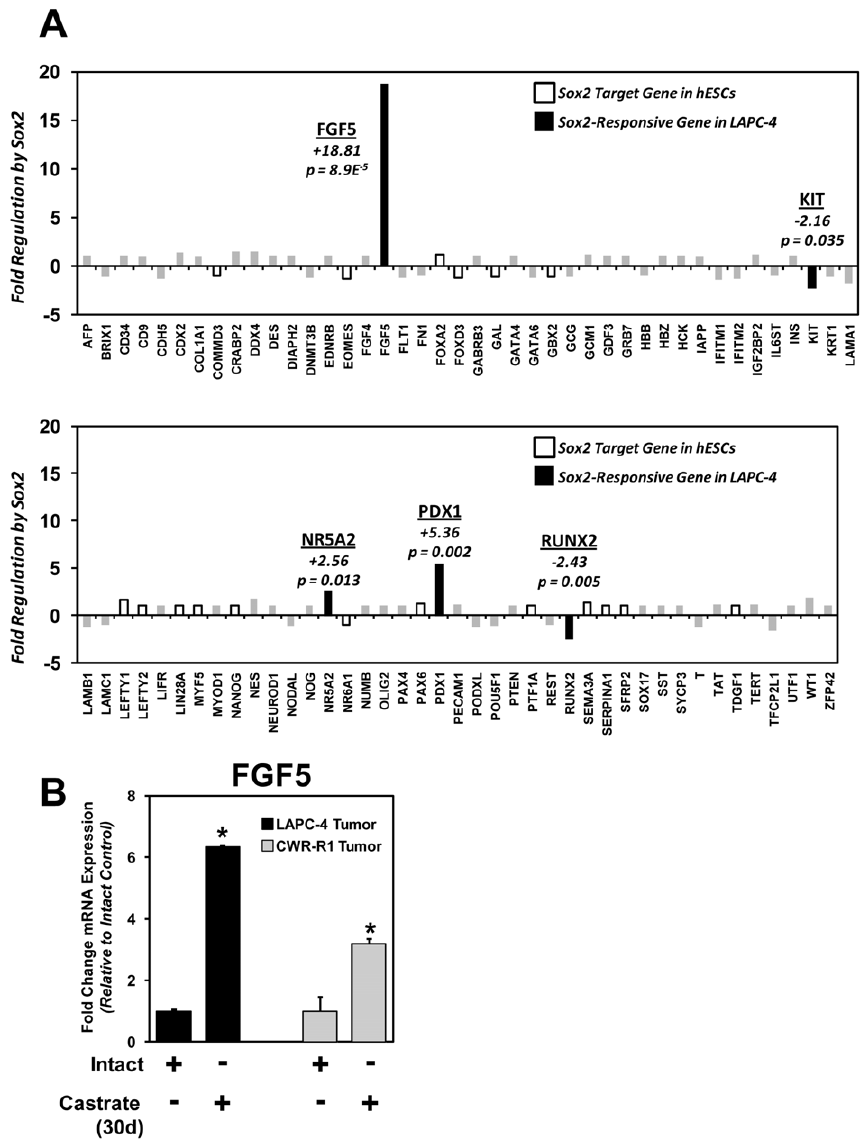
Figure 9. Sox2 expression is associated with the expression of FGF5 and not established human embryonic stem cell Sox2 target genes. A ) The expression of 83 embryonic stem cell-associated genes was analyzed via quantitative real-time PCR analyses to identify Sox2- associated gene changes in LAPC-4-Sox2 cells (compared to LAPC-4-Control cells). Open bars represent genes that are previously identified Sox2- target genes in hESCs (Boyer et al. 2005). No changes in any of these 18 genes were associated with Sox2 expression in LAPC-4 cells. Rather, significant changes in expression were detected for FGF5, Kit, NR5A2, PDX1, and RUNX2 (black bars). B ) Elevated expression of FGF5 in castration- resistant LAPC-4 and CWR-R1 tumors (*p , 0.05; same mRNA as described in Figure